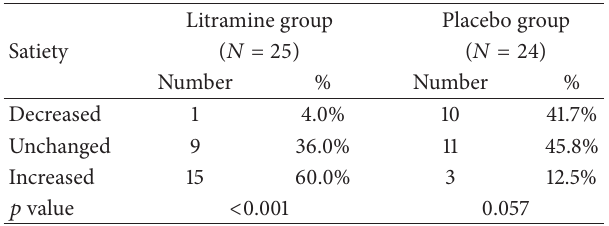
Table 4: Change in feeling of satiety in Litramine and placebo groups between baseline and week